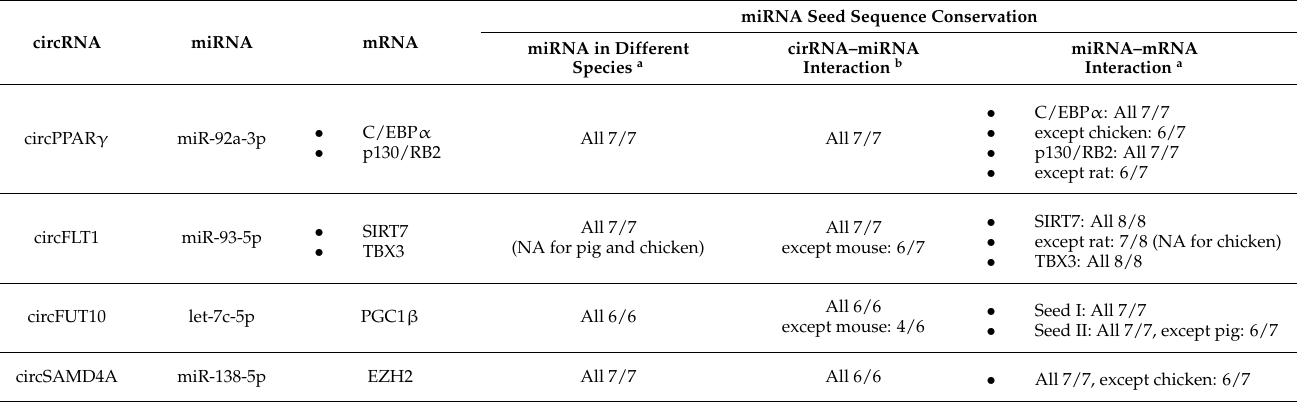
Table 4. Species conservation of miRNA seed sequences and in circRNA–miRNA and miRNA–mRNA